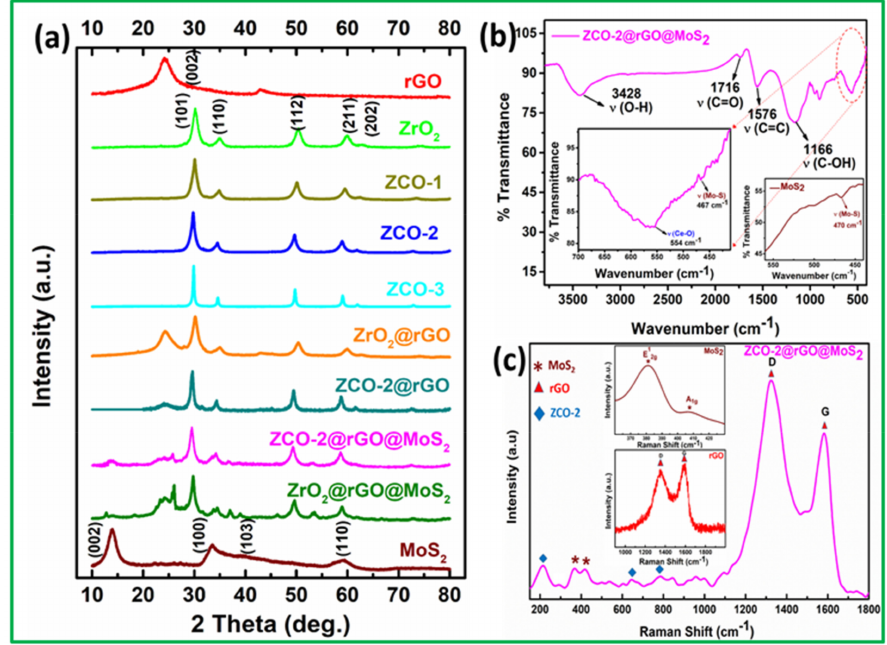
Figure 4. ( a ) X-ray di ff raction (XRD) patterns of as-prepared nano additives, ( b ) Fourier transform infrared spectroscopy (FTIR), inset showing υ Ce-O and υ Mo-S and, ( c ) Raman spectra of ternary composite ZCO-2@rGO@MoS 2 (inset showing spectra of MoS 2 /